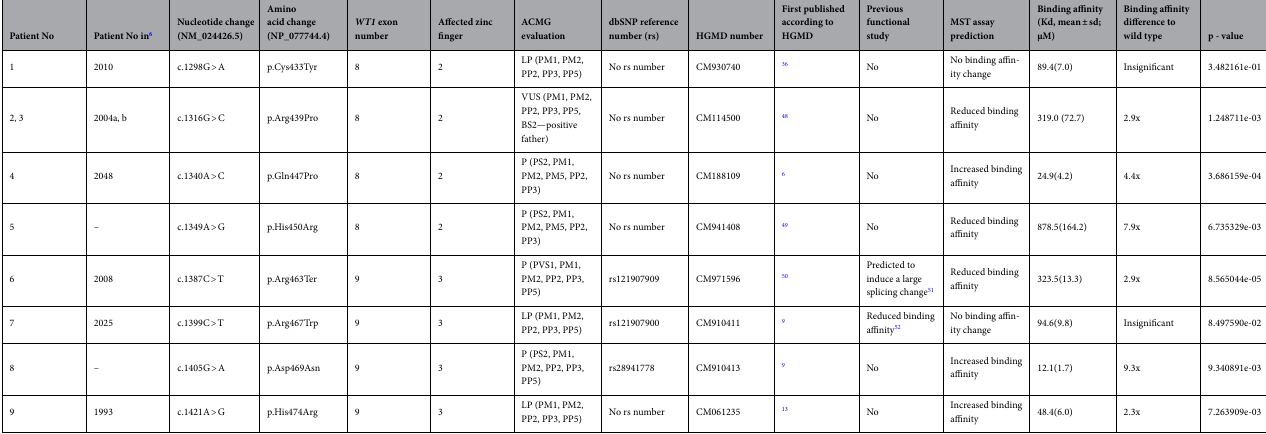
Table 2. Details on WT1 found variants. All variants were found in a heterozygous state and all are absent in databases of global minor allele frequencies. The statistical significance of the difference in mean dissociation constants (Kds) was verified by two-sample t-test computed in R software (p – value). WT1 wild type Kd (MST) = 110.9 μM (mean ± sd = 7.4 μM). P = pathogenic variant; LP = likely pathogenic variant; VUS = variant of uncertain significance; ACMG = American College of Medical Genetics and Genomics standards; HGMD = Human Gene Mutation Database.